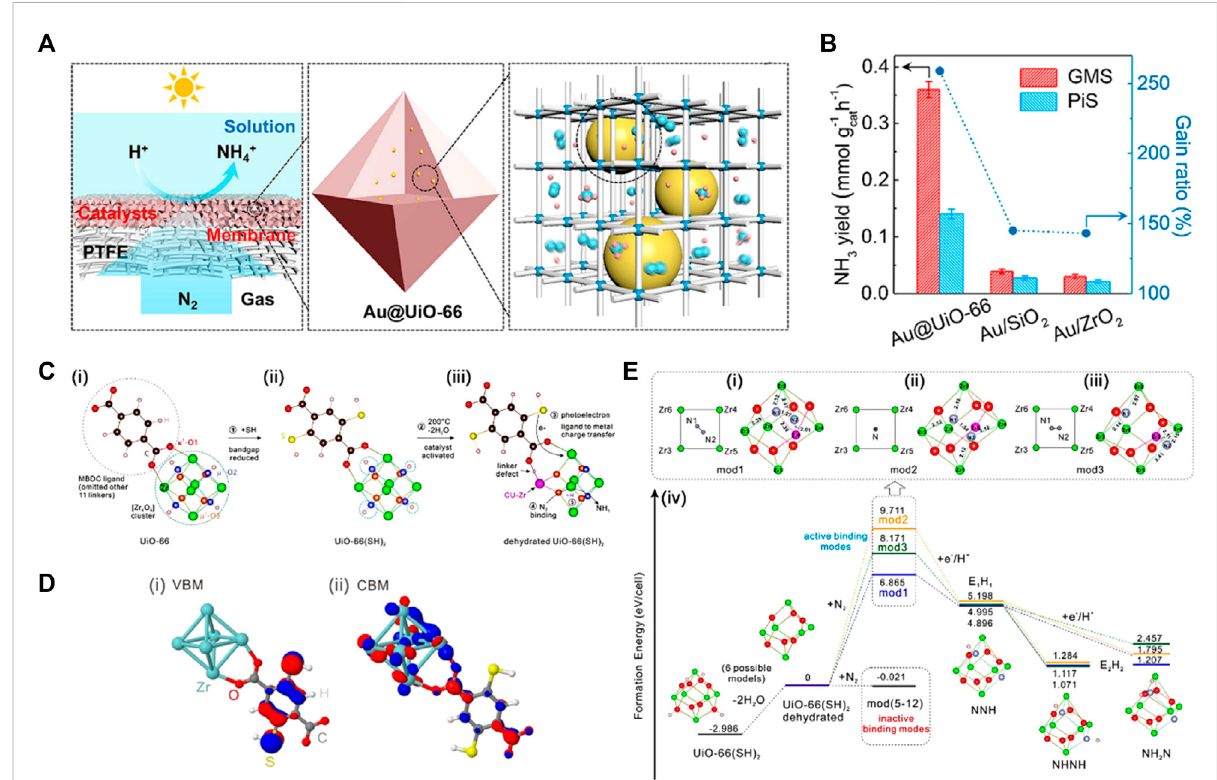
FIGURE 13 (A) SchematicillustrationfordirectNRRonAuencapsulatedinUiO-66matrix. (B) NH 3 yieldonpowder(inthePiSsystem)andmembrane(inthe GMS system) catalysts consisting of Au@UiO-66, Au/SiO 2 , and Au/ZrO 2 . Reproduced from Chen et al. (2021b) with permission from American Chemical Society. (C) Schematic evolution of the partial structure of UiO66, UiO-66(SH) 2 and the dehydrated UiO-66(SH) 2 . (D) The calculated band orbitals for VBM and CBM of UiO-66(SH) 2 at Γ point. (E) The three active modes (mod 1 – 3) with each centerpiece con fi guration of the [Zr 6 O 6 ] cluster encaging N 2 molecule and their corresponding formation energy diagrams. Reproduced from Guo et al. (2022) with permission from the John Wiley and